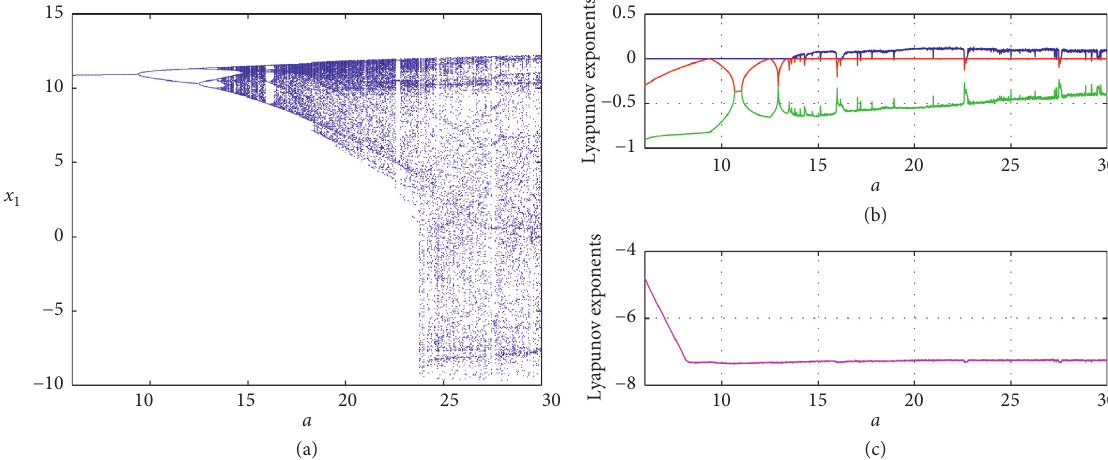
Figure 3: (a) Bifurcation diagram showing local maxima of the coordinate x Lyapunov exponents plotted in the range 6 ≤ a ≤ 30, with c � 1, b � 6, d � 5, e � 2, and m � 1 and initial conditions ( x ( 0 ) , x ( 0 ) , x ( 0 ) , x ( 0 )) � ( 0 , 0 , 2 . 4 , 0 ) 1 2 3 4